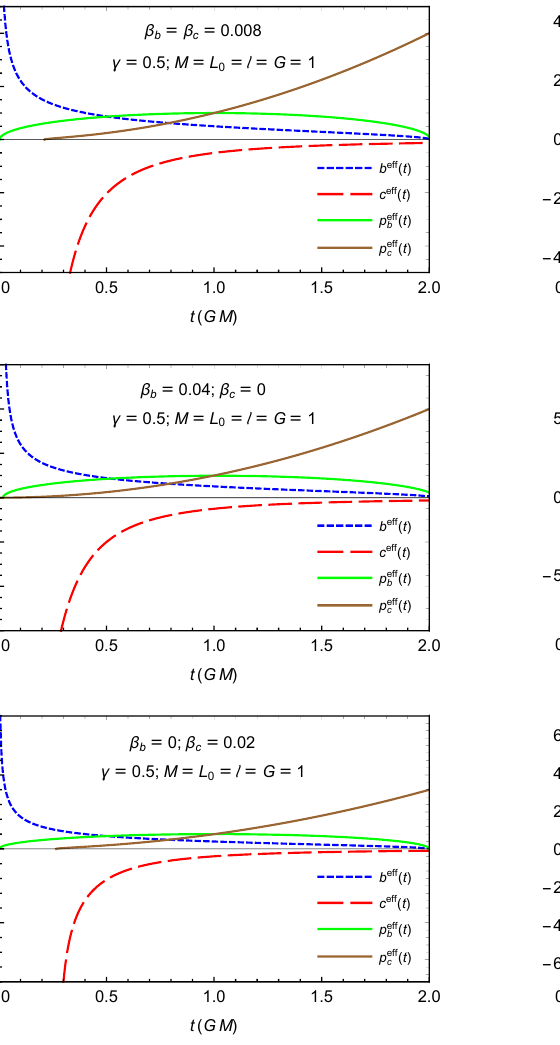
Figure 3 . The behavior of solutions of the modified case in the Schwarzschild time t for positive, negative and vanishing β and β for the whole interior. We have chosen the positive sign for b and b c negative sign for c . Note that for nonvanishing negative β we always get a minimum nonvanishing c value for p , while a nonvanishing negative β leads to a finite value of b at t → 0 . The values of c b parameters are mentioned on each